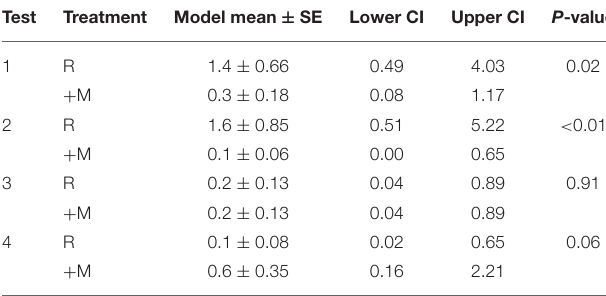
TABLE 5 | The model means of the electrical pulse (EP) ± standard error of mean (SE), upper and lower confidence intervals (CI), and P- value of cows within Treatment across Tests.